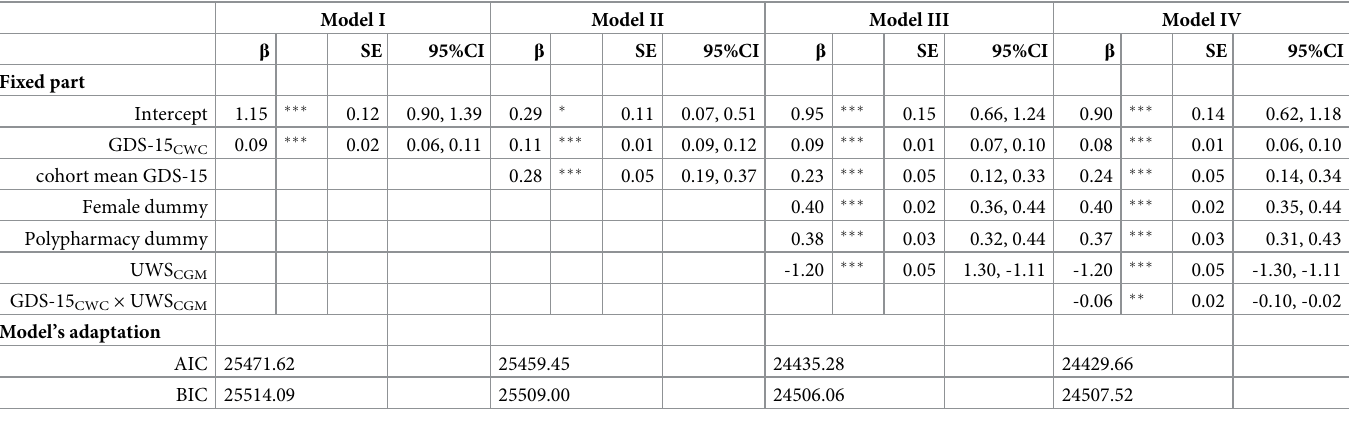
Table 5. Result of random intercept model with a dependent variable of KCL-physical score.